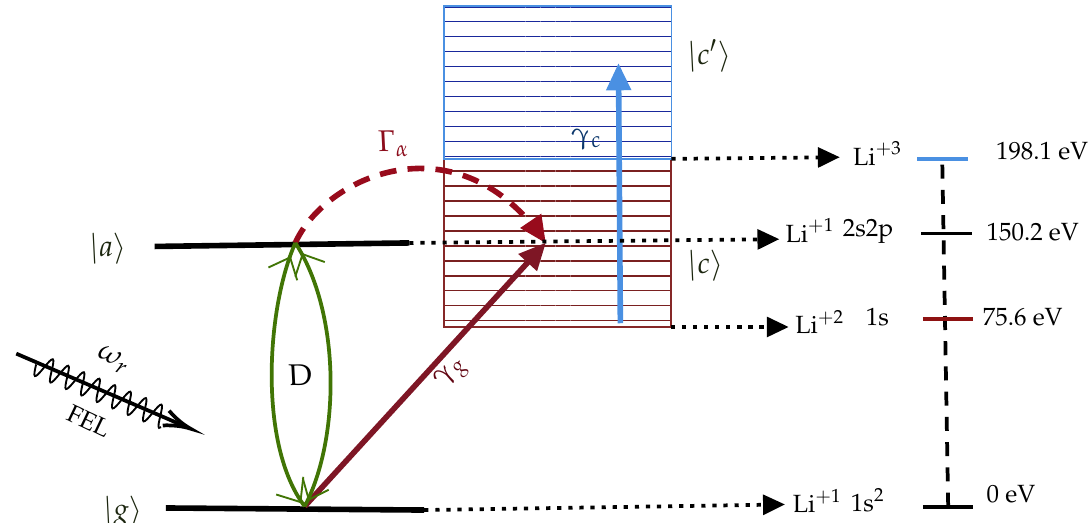
1 s 2 is the ground state, g | i